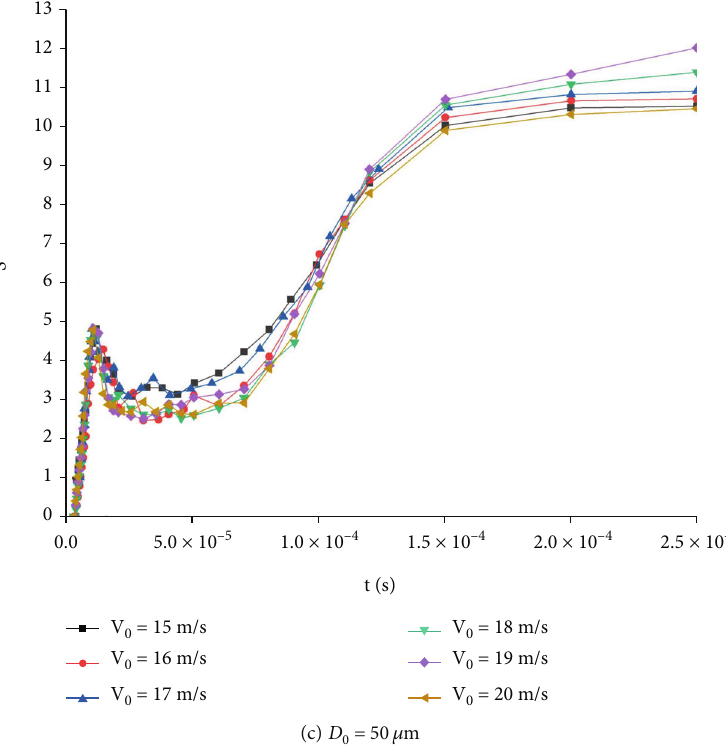
Figure 3: Dimensionless spread area of droplets at di ff erent velocities over